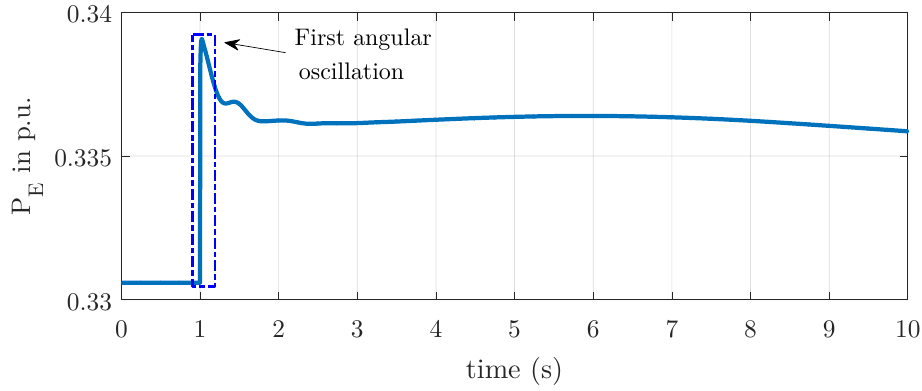
Figure 11. Active power in p.u. at bus 2 (Chicoasen): load increment case.